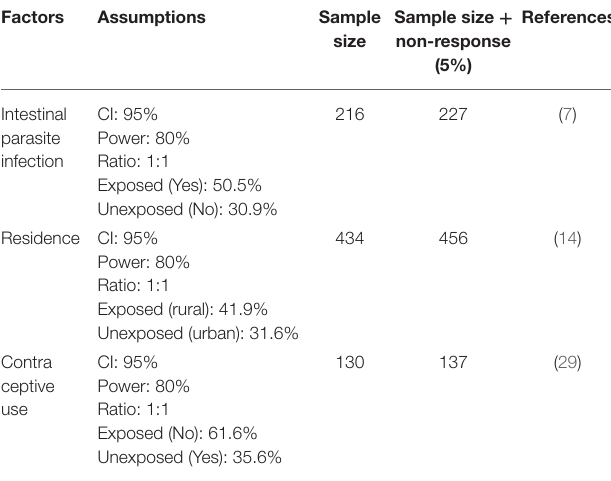
TABLE 1 | Sample size calculation to identify the factors associated with anemia among pregnant women attending ANC in a University hospital in eastern Ethiopia,